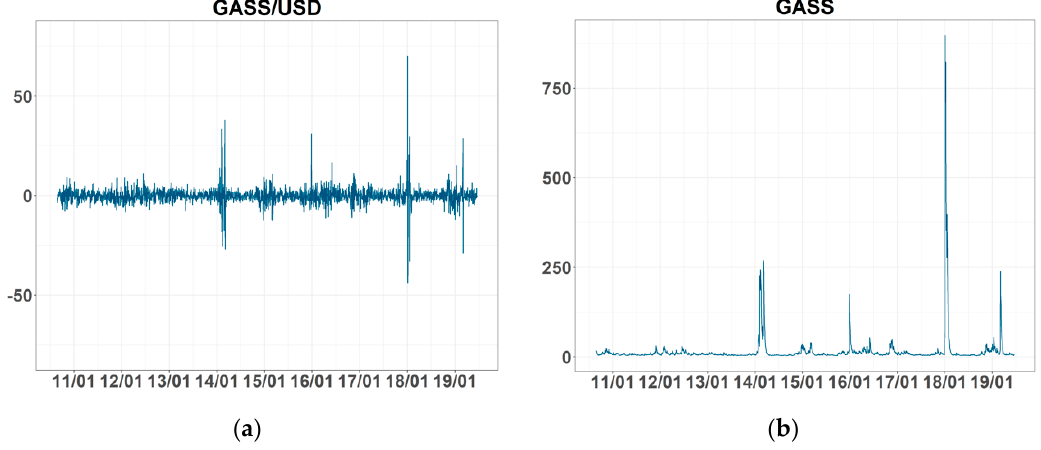
Figure A1. Daily return and volatility: ( a ) return series and ( b ) volatility.